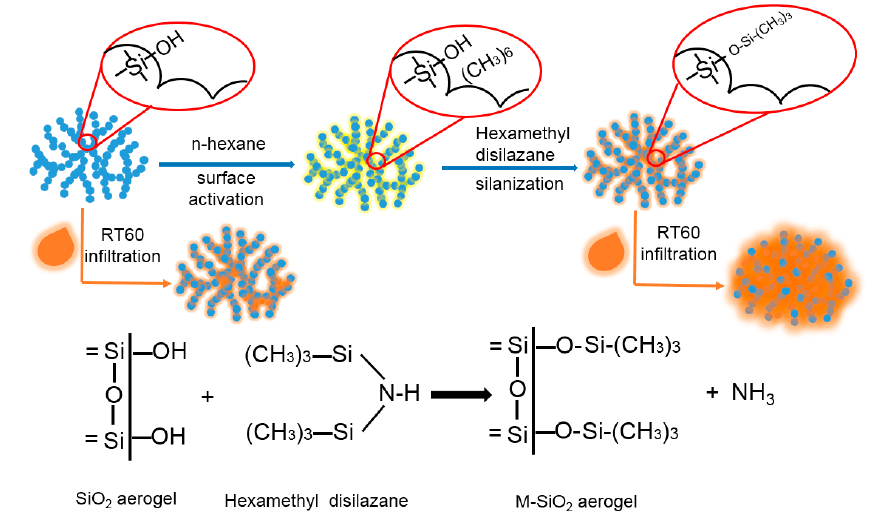
Figure 1. Illustration of M-SiO 2 aerogel and RT60/M-SiO 2 aerogel preparations.